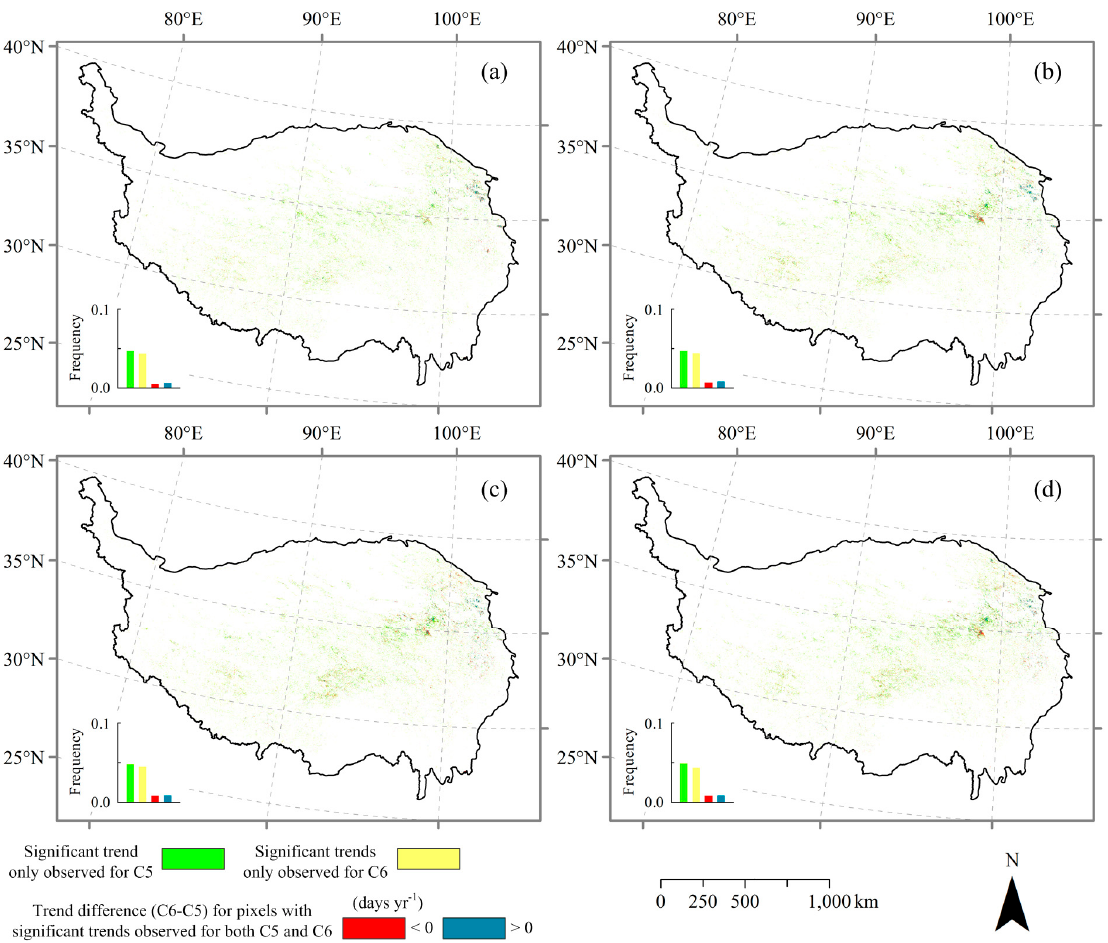
Figure 9. Comparison of trends in end of growing season between C5 (EOS C5 ) and C6 (EOS C6 ) during 2001–2015 for different methods: ( a ) Maximum Curvature Change (MCC); ( b ) Dynamic Threshold 0.2 (DT2); ( c ) Dynamic Threshold 0.5 (DT5); and, ( d ) Maximum Slope (MS).